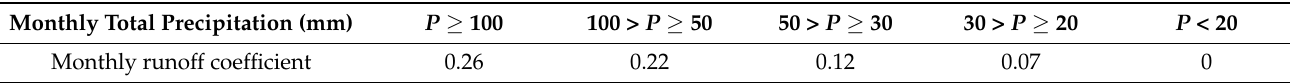
Table 3. Values of the monthly runoff coefficients in the study